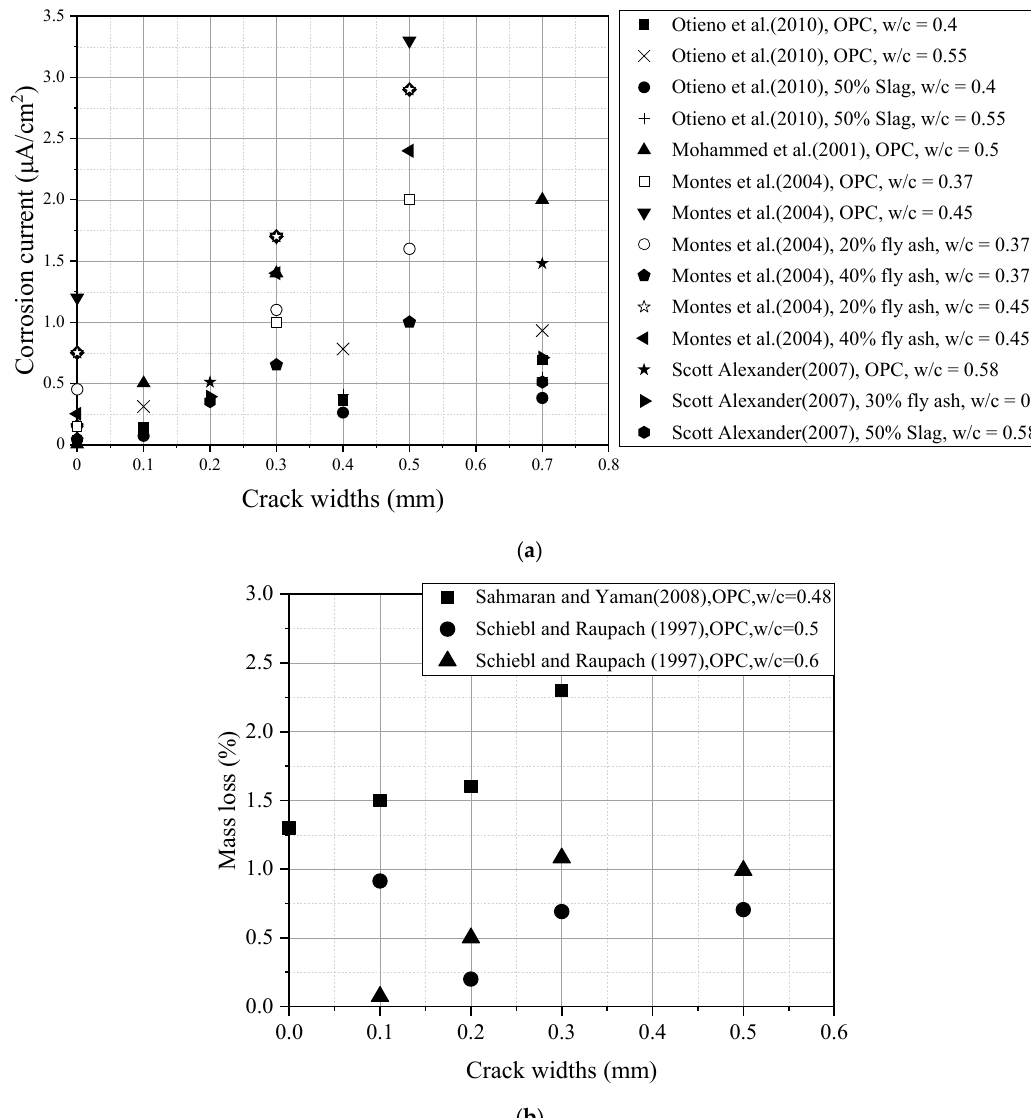
Figure 1. Effect of transvers crack widths on corrosion of steel bar in different concretes. ( a ) Corrosion current (OPC means the Ordinary Portland Cement); ( b ) Steel bar loss to corrosion (OPC means the Ordinary Portland Cement).